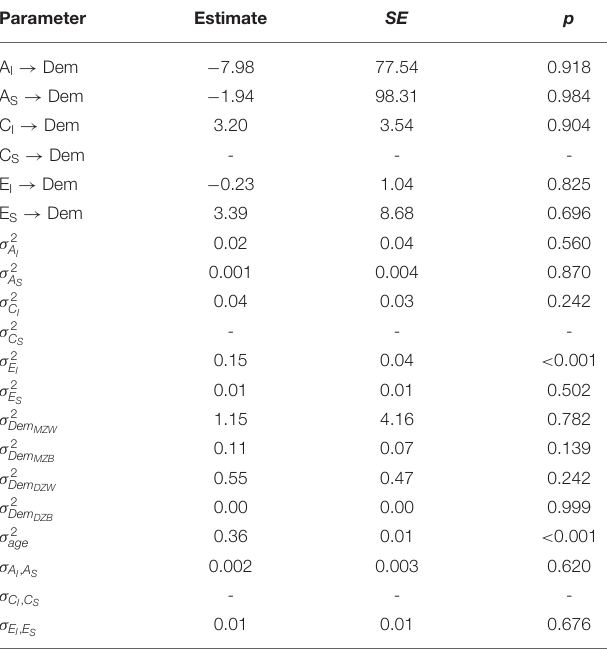
TABLE 3 | Maximum likelihood estimates from the biometric regression model.